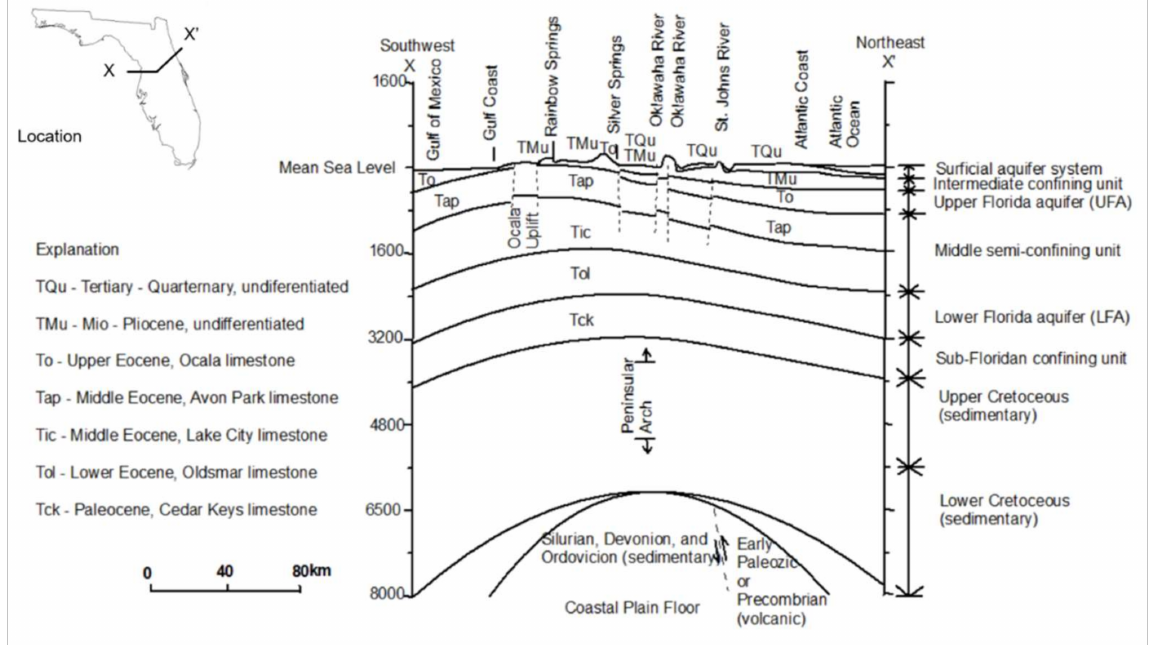
Figure 2. Hydrogeological cross-section (x-x’) of the study area